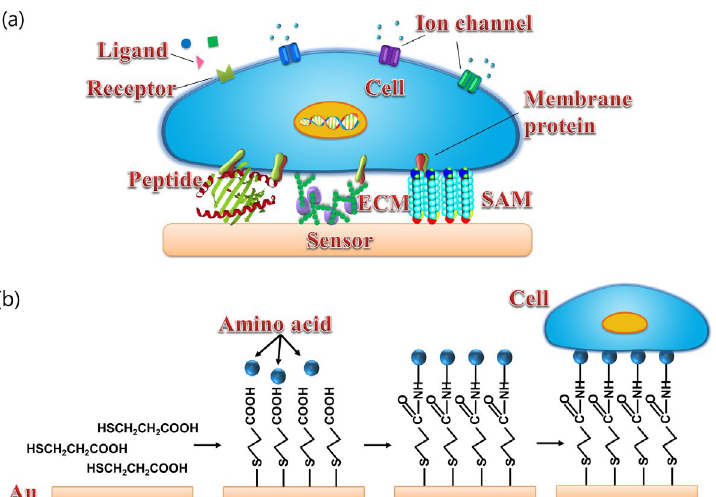
Figure 4. ( a ) Schematics of different surface modification of transducers for cell coupling with sensor including peptide, ECM, and SAM. ( b ) Schematic diagram of cells coupled with gold surface via SAM. (Reprinted with permission from ref. [28]. Copyright 2014 American Chemical Society).